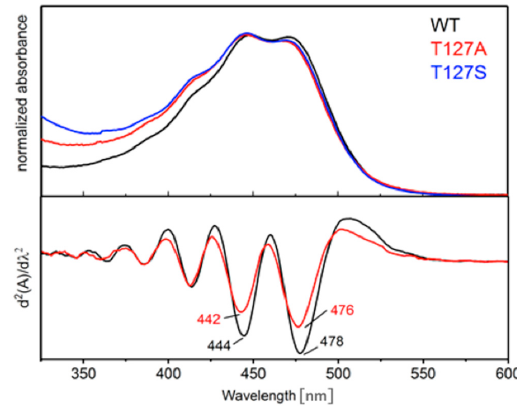
Figure 3. UV / Vis absorption spectra for the Cr ChR2-WT, T127A, and T127S variants. The second derivatives of the absorption spectra are displayed in the bottom panel; the second derivative of the T127S spectrum has been omitted for clarity as it overlaps with the T127A trace.